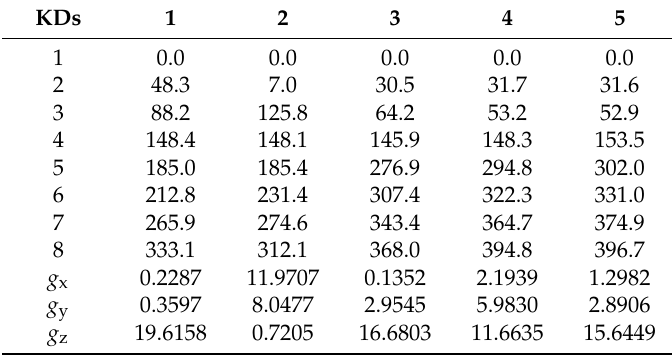
Table 1. Ab Initio Computed Eight Low-lying Kramers Doublet energies (cm − 1 ) and g -tensors of ground Kramers Doublet in 1 – 5